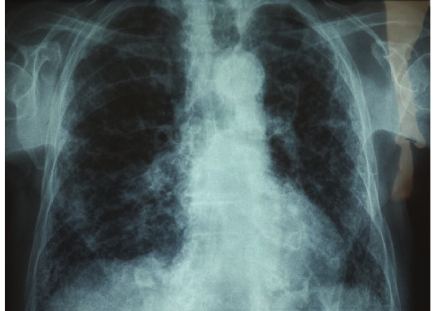
Figure 2: Current X-ray displaying trachea enlargement accompa- nied by fibrotic elements in the lungs.